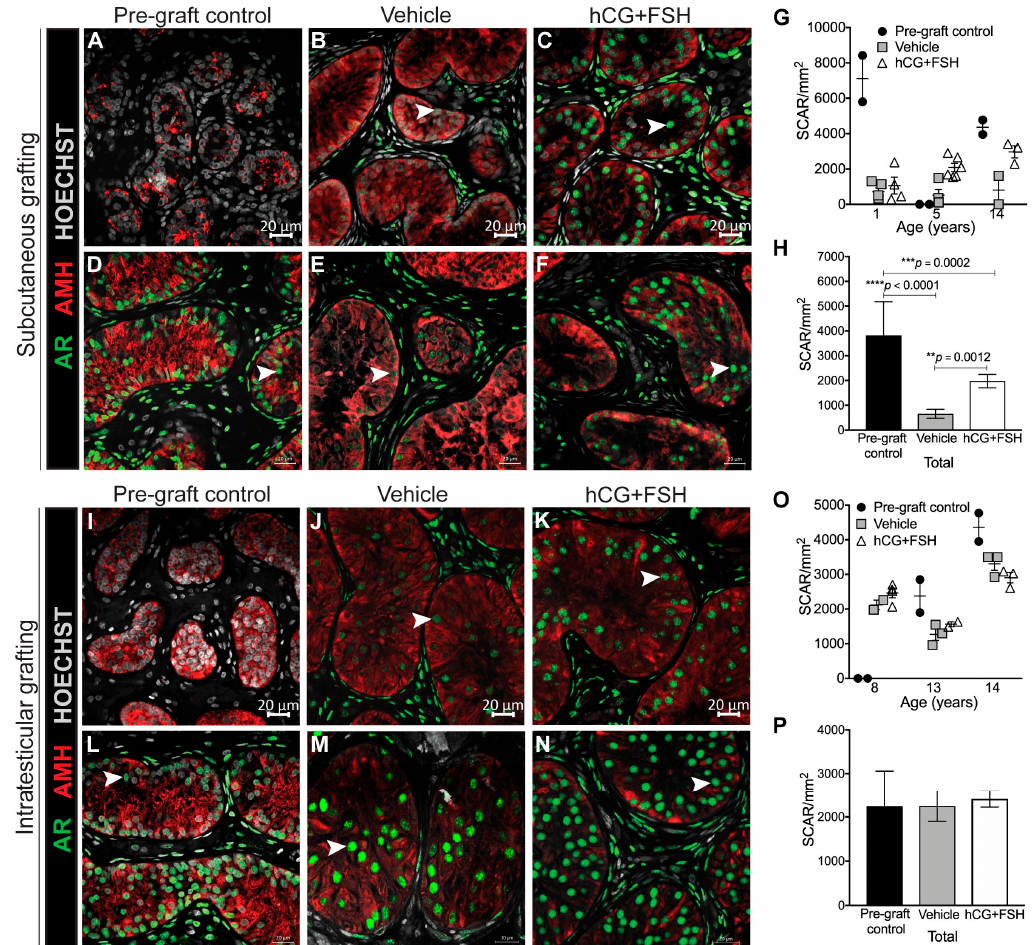
Figure 4. Immunoexpression of AR and AMH in prepubertal human testis xenografts. ( A – C ) Initiation of AR expression in gonadotrophin-exposed subcutaneous xenografts (pre-graft control, 5-year-old). ( D – F ) Maintenance of AR expression in gonadotrophin-exposed subcutaneous xenografts (pre-graft control, 1-year-old). ( G ) Individual data points represent the number of Sertoli Cell Androgen Receptor (SCAR) cells for each subcutaneous graft. ( H ) Graph shows overall mean data. ( I – K ) Initiation of AR expression in gonadotrophin-exposed intratesticular xenografts (pre-graft control, 8-year-old). ( L – N ) Maintenance of AR expression in gonadotrophin-exposed intratesticular xenografts (pre-graft control, 14-year-old). ( O ) Individual data points represent the number of SCAR for each intratesticular graft. ( P ) Graph shows overall mean data. Statistical significance was determined using two-way ANOVA. Data are presented as mean ± SEM ( n = 3 prepubertal testis samples per transplantation site). Arrowheads point to AR + Sertoli